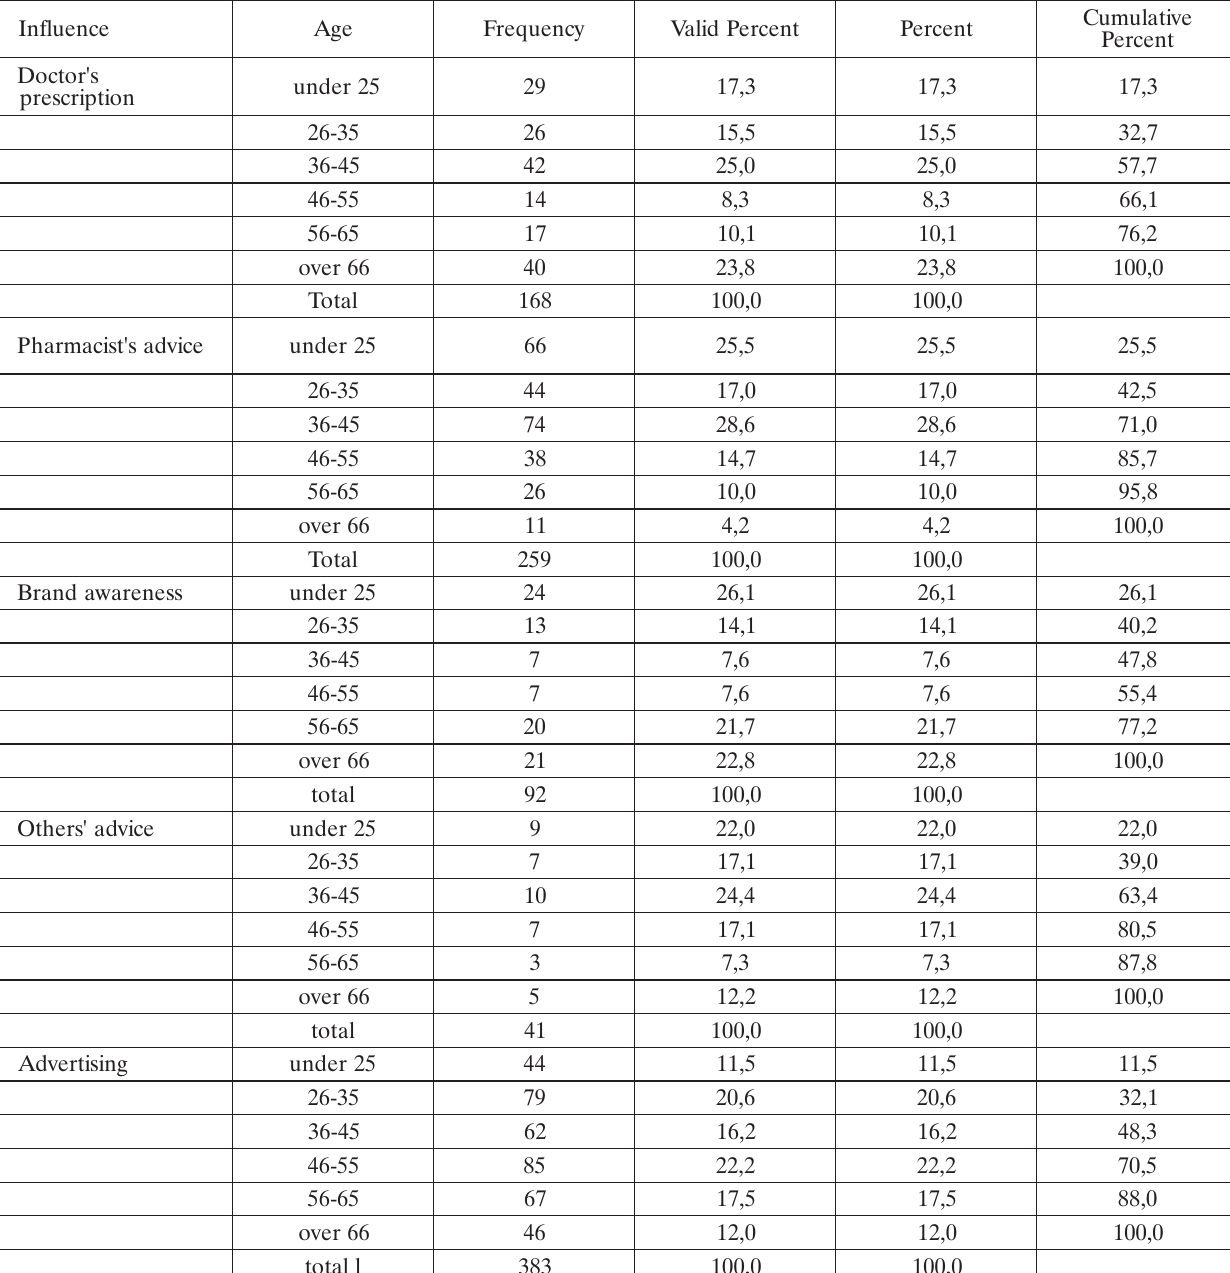
Table 3. Respondents’ distribution according to age and the influence on decision making to purchase